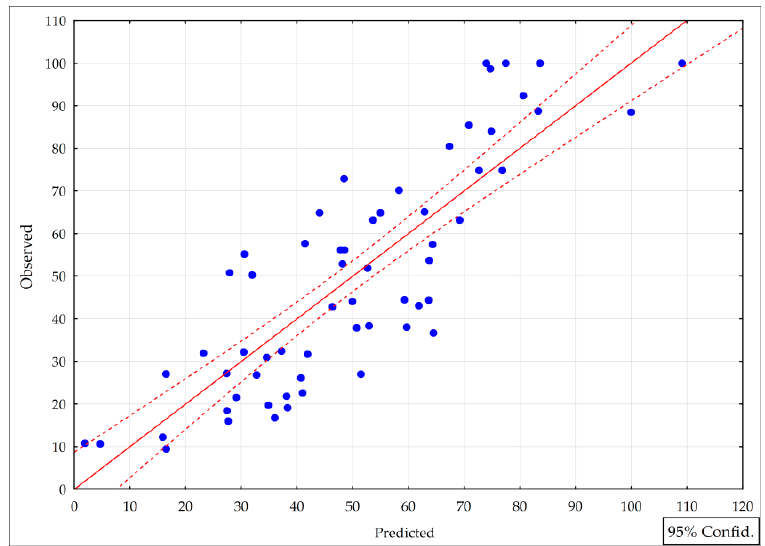
Figure 6. Relationship between observed soil moisture (SM) and calculated from Sentinel-1 VH data through statistically derived algorithm. Table 5. Results of the relationships at the 95% confidence level between measured SM and calculated SM from Sentinel-1 VV and VH data.